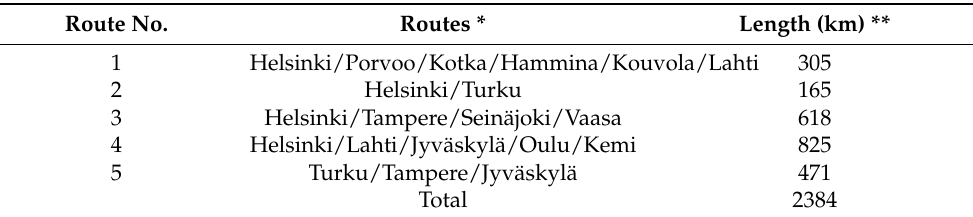
Table 4. Finnish electric road route scenario based on the highest demand for heavy road freight transport. Route No. Routes * Length (km)